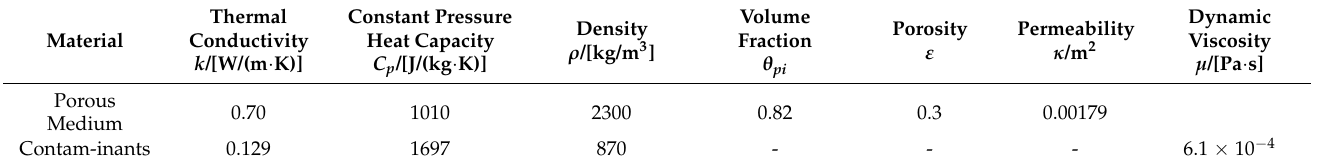
Table 1. Heat transfer simulation parameters of porous